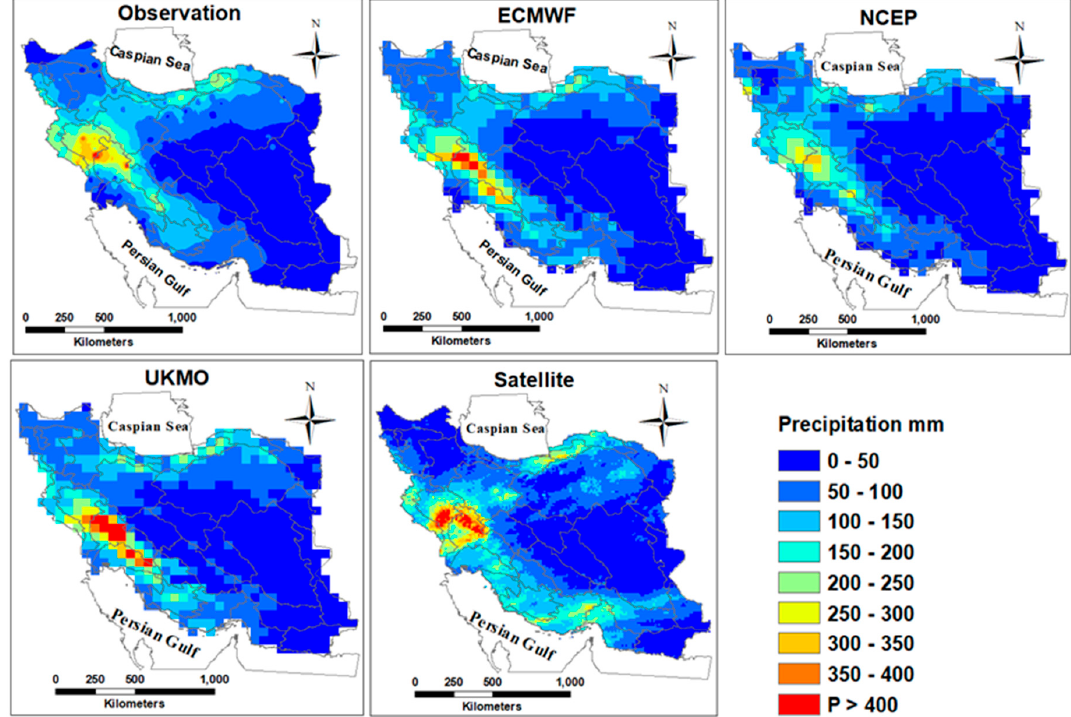
Figure 2. Spatial distribution of accumulated precipitation (mm) from the observational, ECMWF, NCEP, UKMO, and IMERG satellite for 19 precipitation days over Iran.